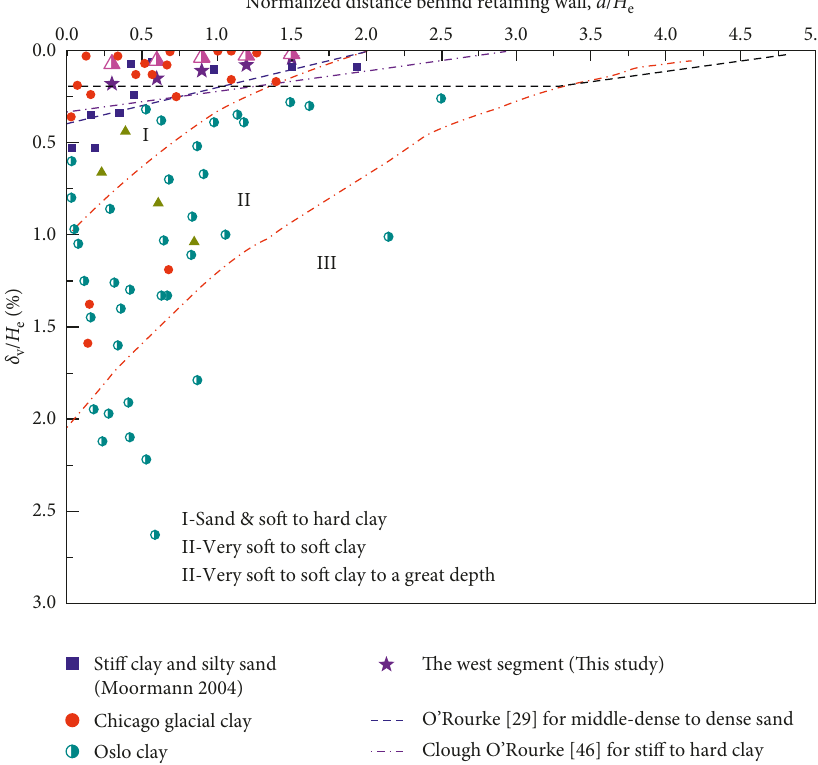
Figure 14: Observed ground settlement profiles versus those predicted by empirical methods. (a) Relationship between δ Relationship between δ v / δ v,max and d / H e